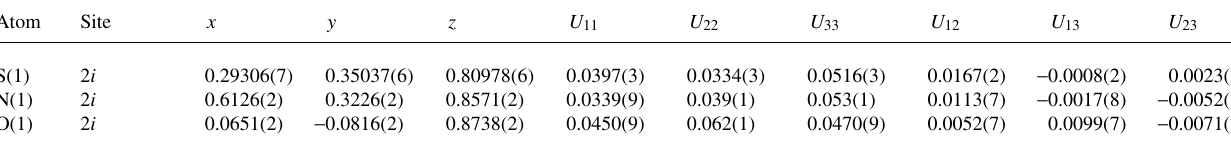
Table 3. Atomic coordinates and displacement parameters (in Å 2 )